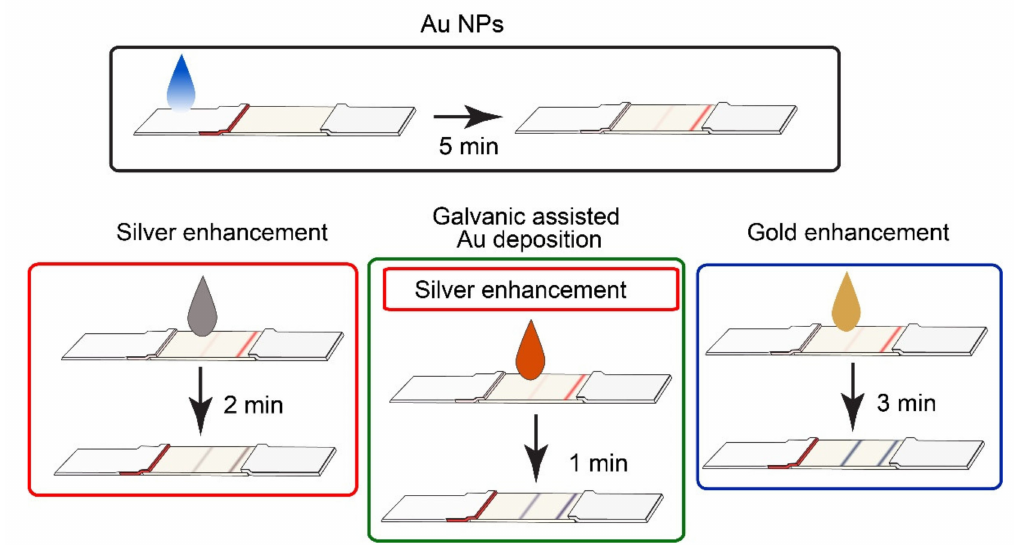
Figure 2. Four formats of LFIA used in the article. Test strips after completion of LFIA with Au NPs (black frame) were used for silver enhancement (red frame), galvanic-assisted Au deposition (green frame), and gold enhancement (blue frame). The galvanic-assisted Au deposition included silver enhancement (depicted as the nested red